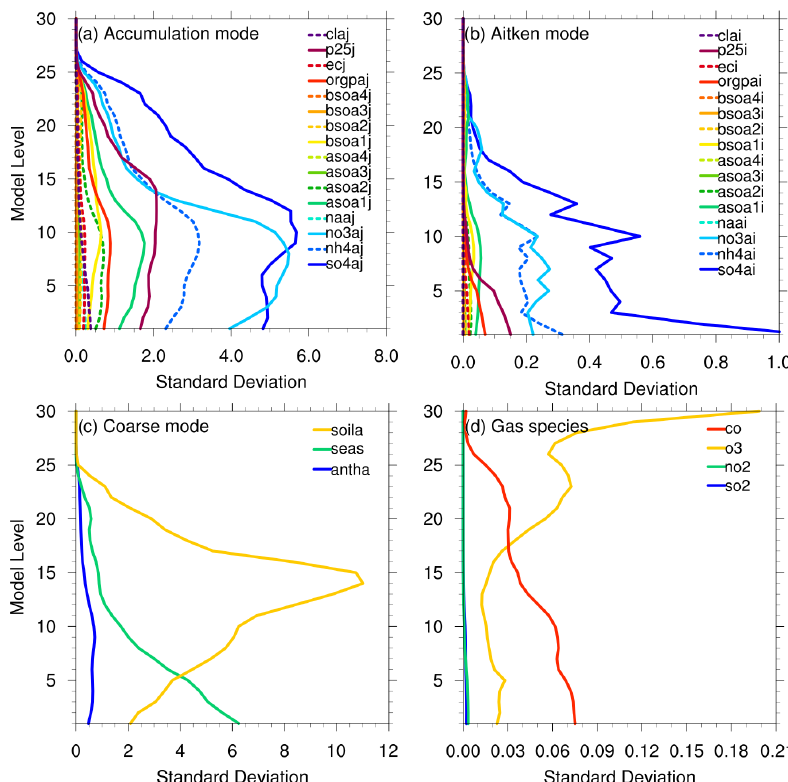
Figure 2. Vertical profile of background error standard deviations for aerosol species in (a) accumulation, (b) Aitken, and (c) coarse modes, and (d) gas species over domain